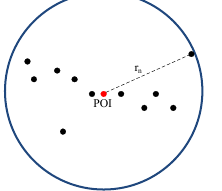
Figure 1. 3D neighbourhood of the point in question (POI)